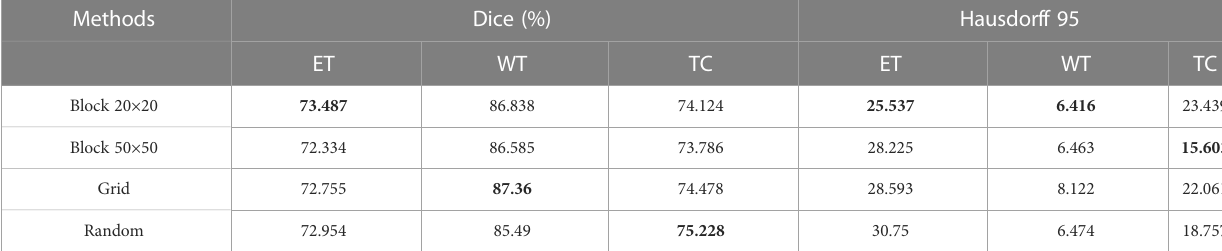
TABLE 6 Ablation experiment results on the masking strategies on BraTS 2020.